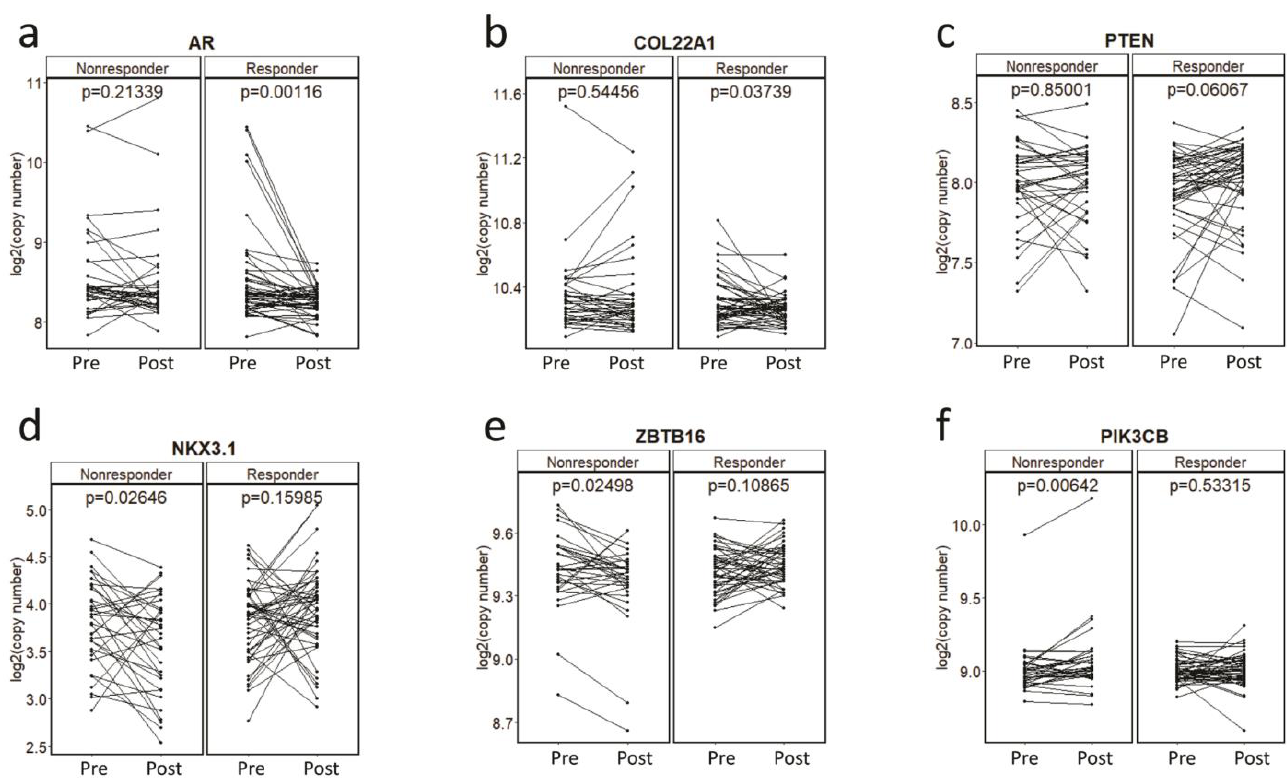
Figure 2. Copy number changes during the AA/P treatment. Copy number changes at AR ( a ), COL22A1 ( b ), PTEN ( c ), NKX3.1 ( d ), ZBTB16 ( e ), PIK3CB ( f ) before (pre-) and 3-month after (post-) abiraterone acetate and prednisolone (AA/P) treatment in responders and non-responders in the PROMOTE cohort. p values are calculated by paired t -test.